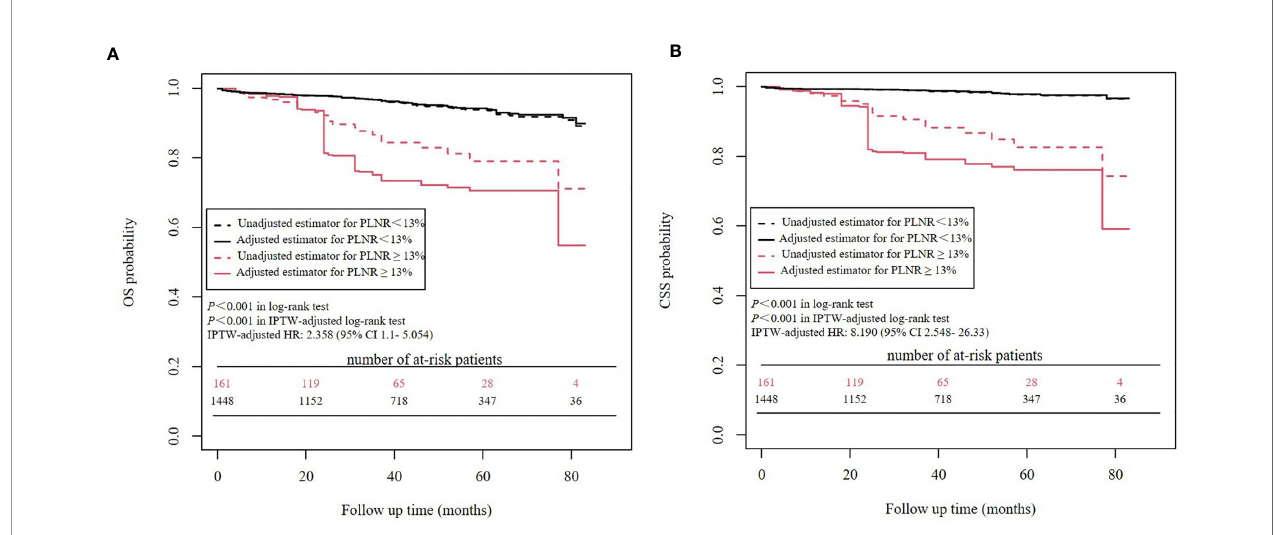
FIGURE 4 | Survival analysis of PLNR before and after IPTW. (A) OS analysis (B) CSS